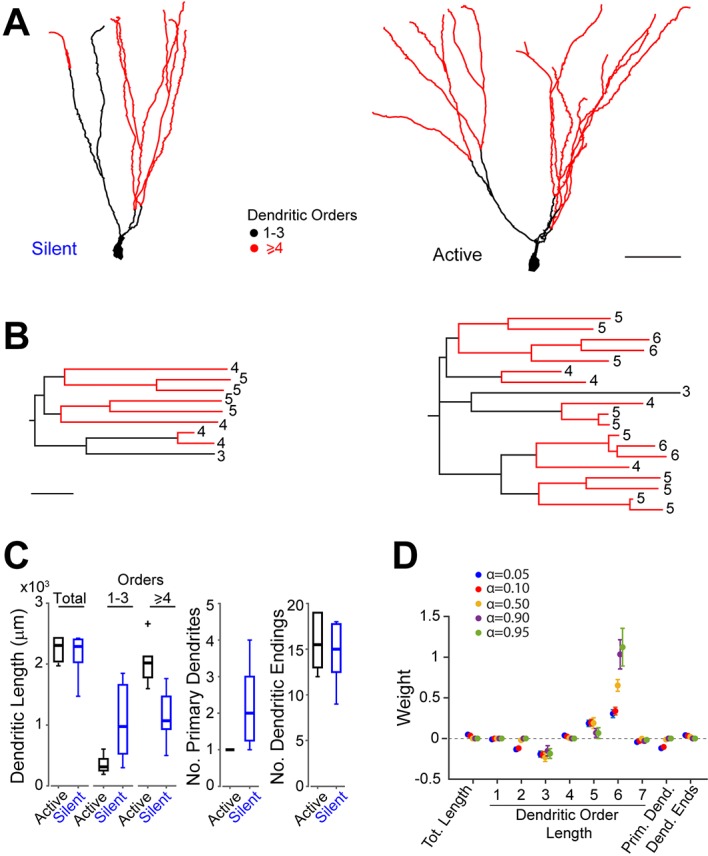
Morphological analysis of identified active and silent granule cells.(A) Somatodendritic reconstructions of silent (left, cell id 993) and active (right, cell id 102) GCs, recorded in freely moving rats. Dendritic branch orders 1–3 are indicated in black, while high-order branches (≥ 4) are indicated in red. Scale bar=50 µm. (B) Dendrograms for the cells in (A). The branch orders of the terminal dendritic tips are indicated. Color codes same as in (A). Scale bar=50 µm. (C) Box-plots comparing primary dendritic parameters (active GCs, n=6; silent GCs, n=7). Whiskers represent 1.5 IQR. Outliers are shown as crosses. (D) Weights of logistic regression classifier (mean ± SEM over cross-validation folds) used for classifying GCs as active or silent for different levels of sparseness (α=0.05 corresponds to dense weights, α=0.95 corresponds to sparse weights).DOI:
http://dx.doi.org/10.7554/eLife.20252.00710.7554/eLife.20252.008Figure 4—source code 1.Classification analysis.Matlab script to load Figure 4—source data 1, run the logistic regression classification analysis on primary morphological features (Figure 4D), perform the shuffle analysis and run the control analysis with all morphological features.DOI:
http://dx.doi.org/10.7554/eLife.20252.00810.7554/eLife.20252.009Figure 4—source data 1.Electrophysiological and morphological parameters of the identified GCs.The table summarizes the main electrophysiological and morphological properties of the identified and reconstructed silent and active GCs (source data for Figure 4). Morphologies of the neurons are shown in Figure 4—figure supplement 1.